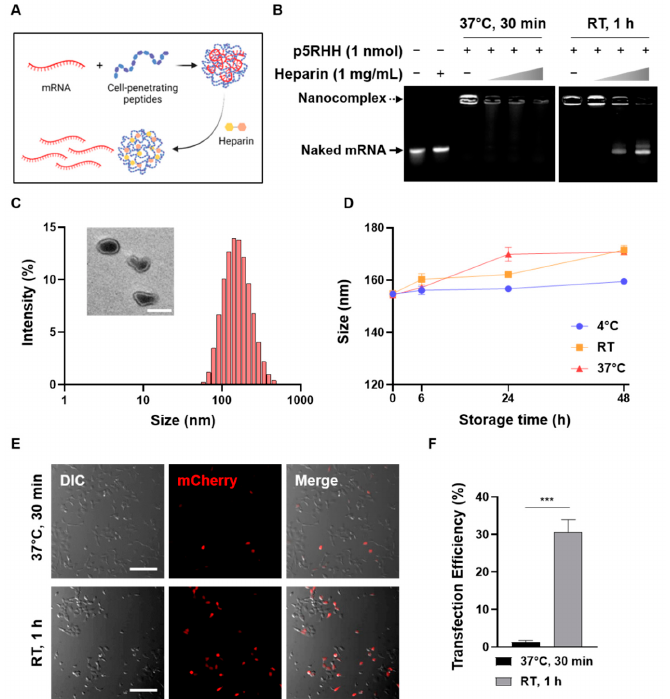
Figure 1. Optimization of CPP/mRNA complex formation. ( A ) Schematic showing CPP/mRNA complexation and heparin-mediated decomplexation. ( B ) Agarose gel images showing the decom- plexation of p5RHH/mCherry mRNA complexes incubated under two different conditions. Solid arrow represents naked mCherry mRNA and dashed arrow represents p5RHH/mCherry mRNA com- plexes. ( C ) Size distribution diagram and representative TEM image of p5RHH/mRNA complexes. Scale bar: 100 nm. ( D ) Size stability of p5RHH/mRNA complexes at various storage temperatures. ( E ) Representative fluorescence images of HEK293T cells after treatment with 3 µ g of p5RHH/mCherry mRNA complexes mixed with the indicated conditions. Scale bar: 200 µ